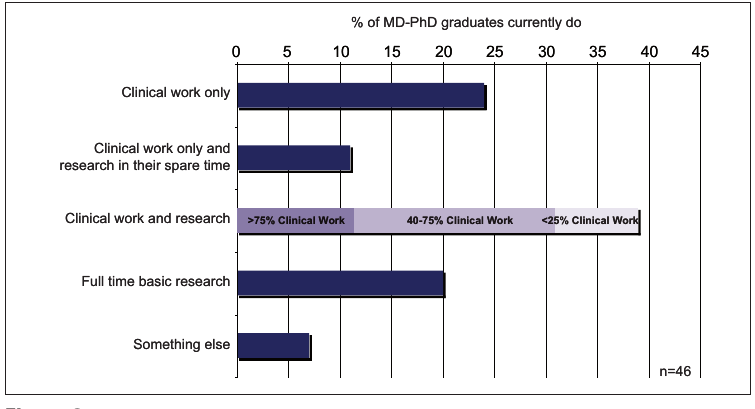
Professional time allotment of MD-PhD